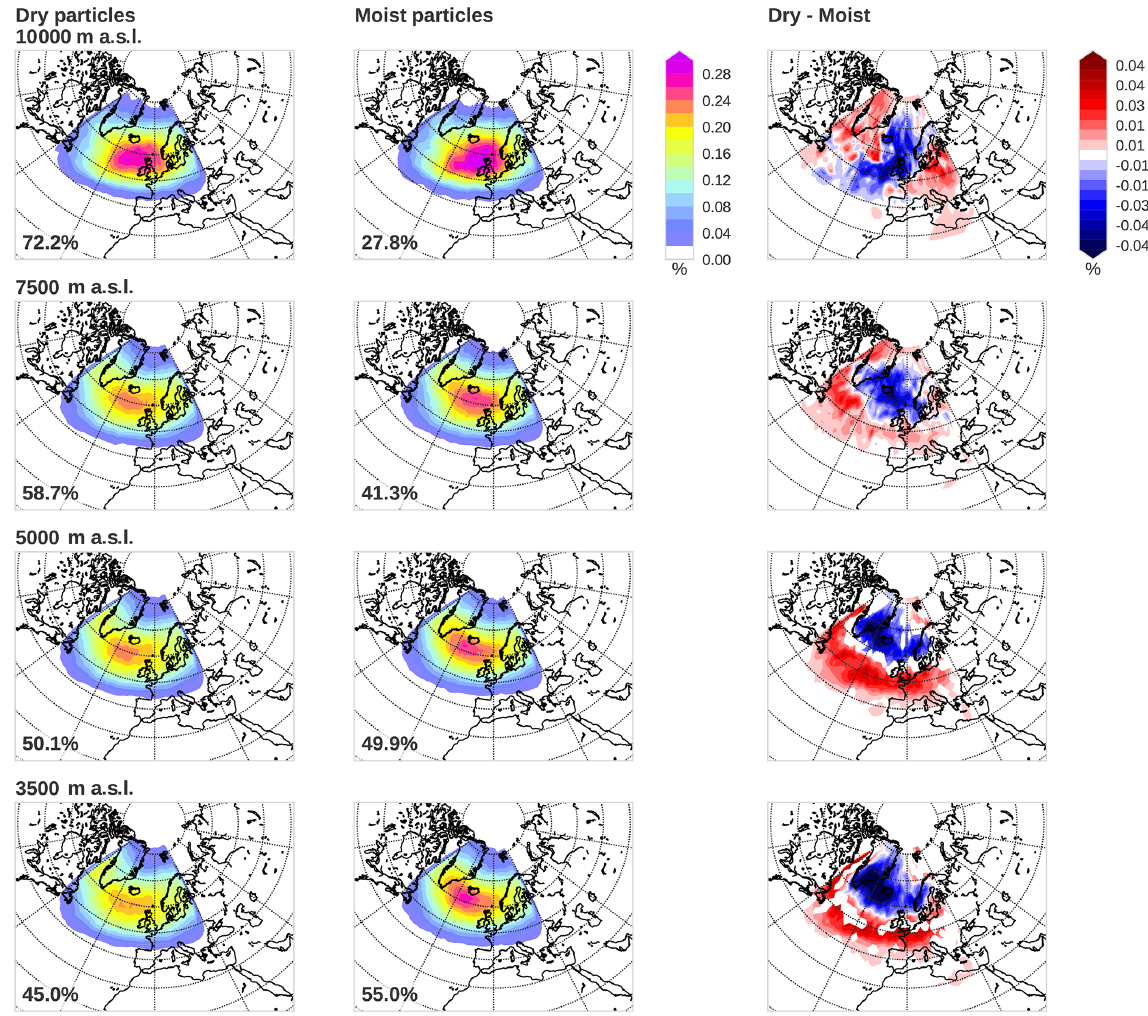
Figure 6. The number density of dry (left column) and moist particles (middle column) and their difference after being normalized by the total particle number of each category (right column) for each 2 ◦ × 2 ◦ grid cell at the time of their release from the block regions separately for the release altitudes of 10000ma . s . l . (top), 7500ma . s . l . (second row), 5000ma . s . l . (third row), and 3500ma . s . l . (last row). The numbers indicated in the bottom left corner for the left and middle columns denote the percentages of dry and moist particles released from each altitude, respectively. Only the grid cells where statistical difference is significant at the 95% confidence level are shaded in the third column. Parallels are plotted for every 10 ◦ , whereas meridians are plotted for every 30 ◦ on each